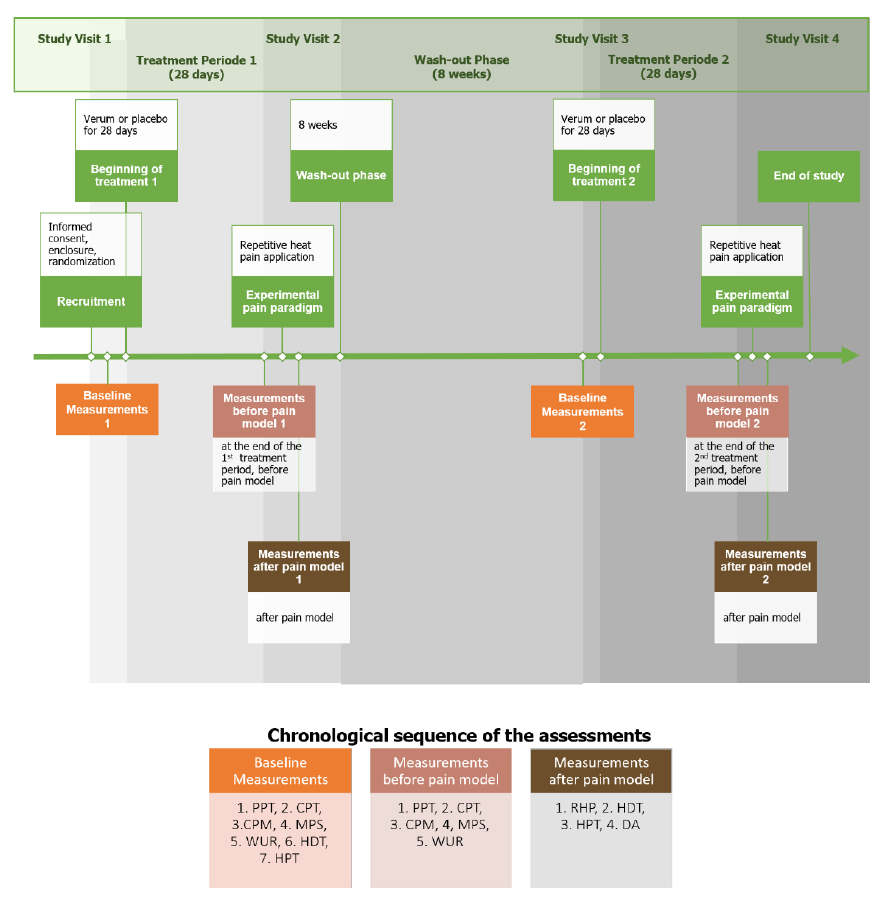
Figure 1. Schematic chart of the course of the study. The assessments were performed in the se- quence presented in the chart. CPM: conditioned pain modulation, CPT: cold pain threshold, DA: distance of allodynia, HDT: heat detection threshold, HPT: heat pain threshold, MPS: mechanical pain sensitivity, PPT: pressure pain threshold, RHP: repetitive heat pain, WUR: wind-up ratio.